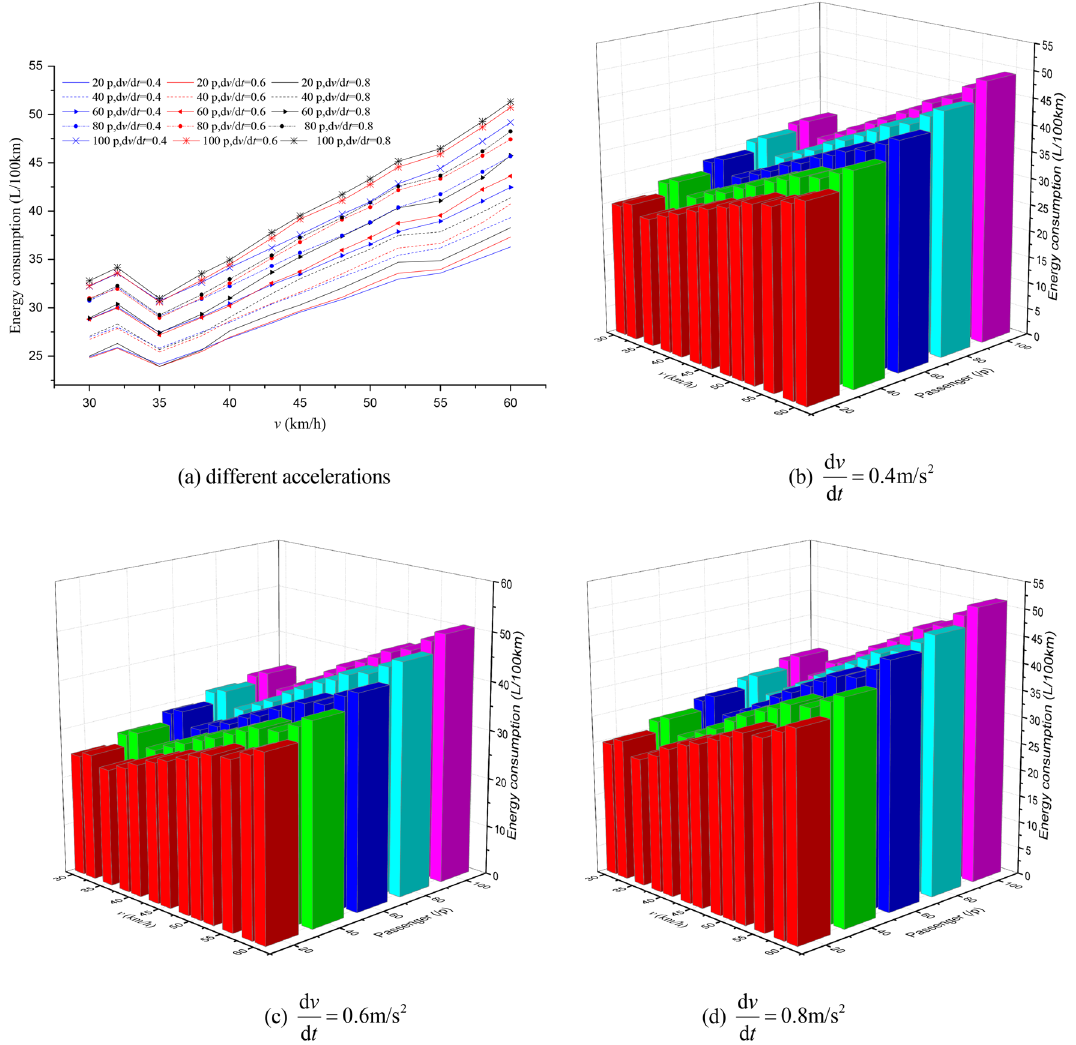
Figure 8. The EC of different passenger load, acceleration and maximum speed for 600 m station